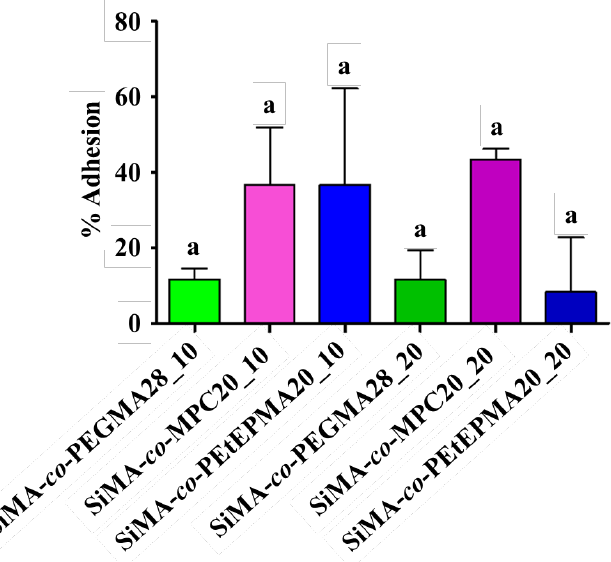
Figure 5. Mean percentage of adhesion of F. enigmaticus competent larvae on different surface samples, after five days of exposure. An ANOVA analysis (n = 6) followed by a Tukey post-hoc test were performed for multiple comparisons. Not-shared letters indicate statistically significant differences, p ≤ 0.05. Adhesion percentage for PDMS was 16.67 ± 6.83% (mean ± standard deviation).